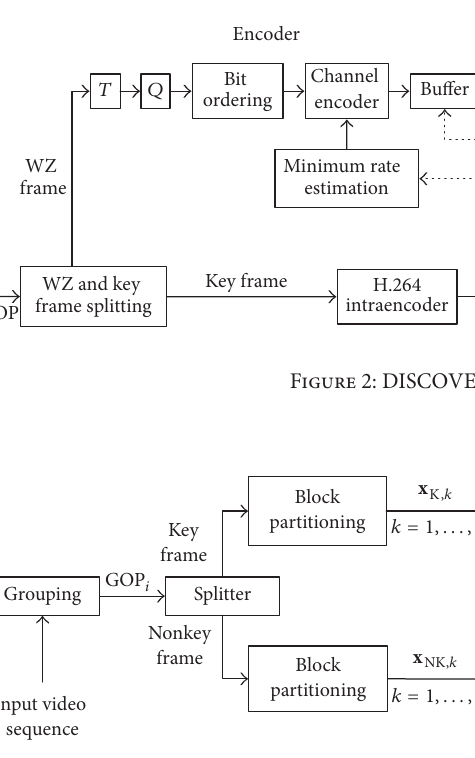
Figure 3: CSVC encoder